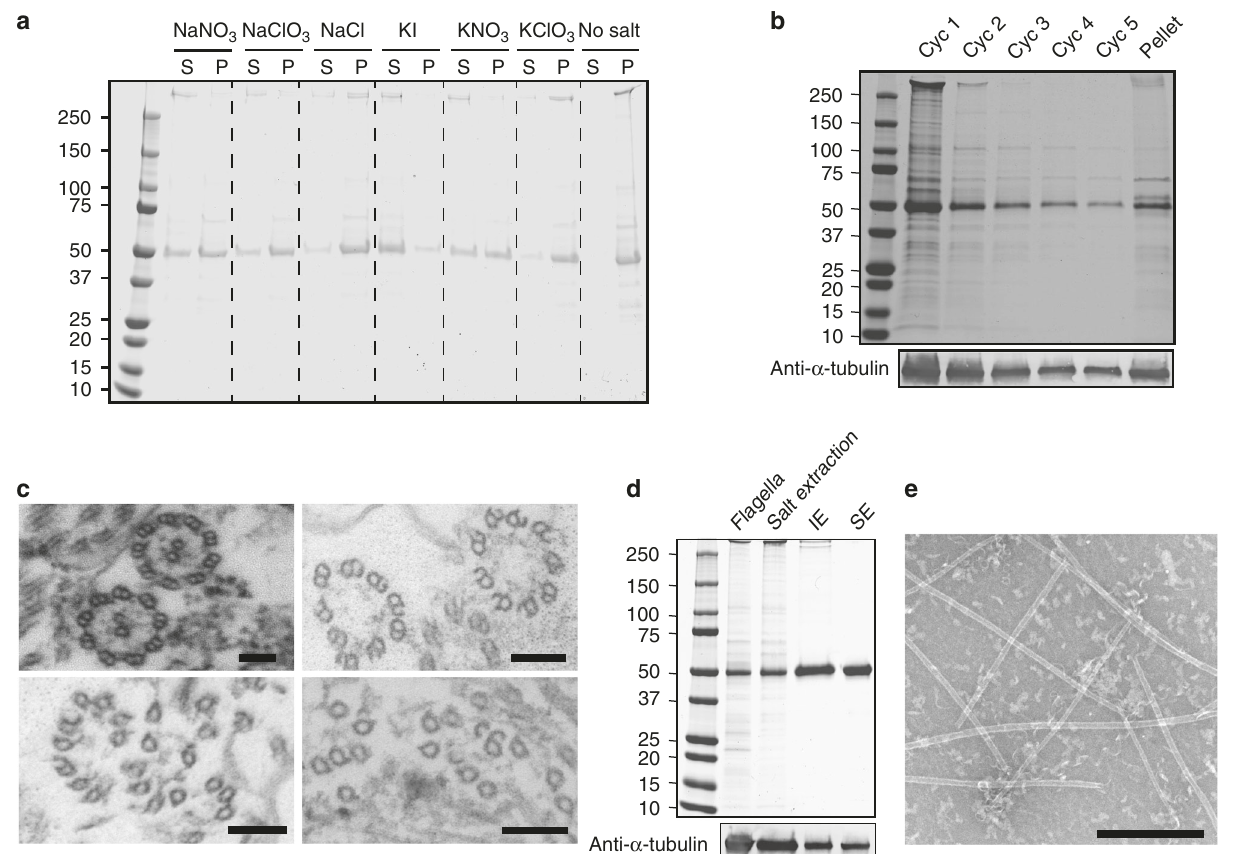
Fig. 1 Puri fi cation of axonemal tubulin and MTs reconstitution. a SDS-PAGE of supernatant (S) and pellet (P) axoneme samples after salt extraction (500 mM). Supernatant contains soluble axonemal tubulin (50 kDa), while the pellet contains tubulin from insoluble axonemes. b SDS-PAGE of supernatant samples from fi ve cycles of 500 mM NaNO 3 salt extraction, and the pellet at the end. c Transmission electron microscopy micrographs of intact axoneme (top left) and axonemes after 1 cycle (top right) 2 cycles (bottom left) and 5 cycles (bottom right) of salt extraction with 500 mM NaNO 3 . Scale bar: 100 nm. d SDS-PAGE of samples collected throughout the axonemal tubulin puri fi cation. From left to right: Flagella lysate, supernatant of the axonemes after treating them with 500 mM NaNO 3 salt extraction, Hi-Trap Q (IE) elution fractions, size exclusion (SE) elution. e TEM micrograph of taxol-stabilized reconstituted axonemal MTs. Scale bar: 500 nm. Source data are provided as a Source Data fi